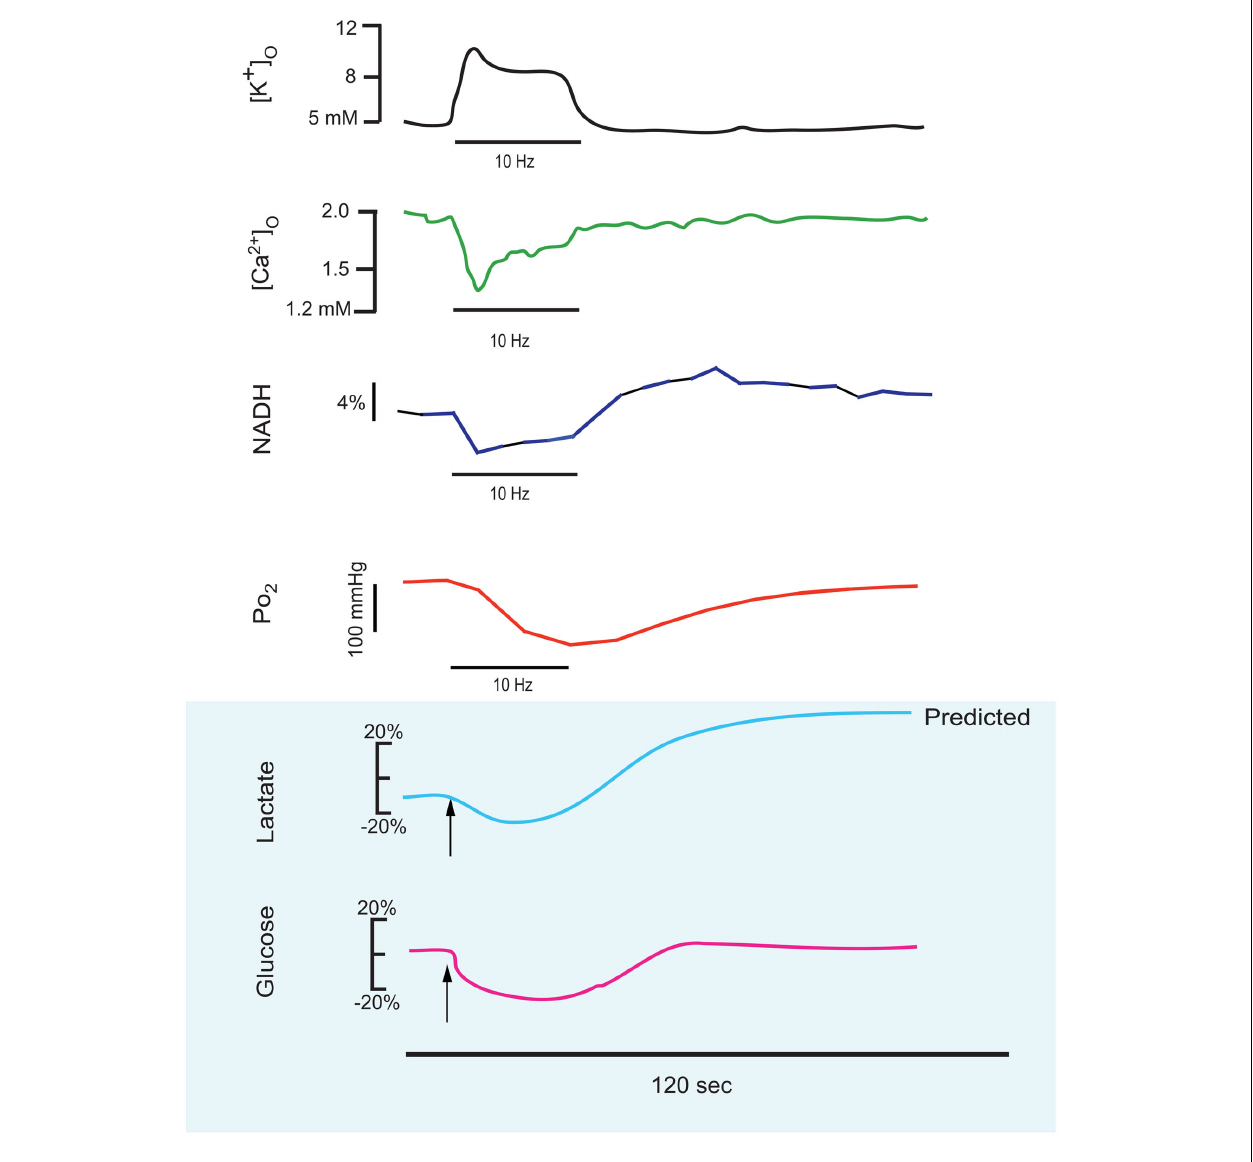
FIGURE 1 |This series of traces illustrates the response to a 10–25 short stimulus train applied to the stratum radiatum of the CA1 region of an in vitro hippocampal tissue slice, and the physiological responses which can be measured in real-time during this stimulus train. These reconfigured traces have been redrawn from primary sources to be on the same time scale (shown as 120s below). Measured responses include extracellular K + and Ca 2 + (Benninger et al., 1980) and NADH imaging and tissue PO 2 (Galeffi et al., 2007). Predicted in vitro tissue slice responses are shown below with blue shading, with lactate